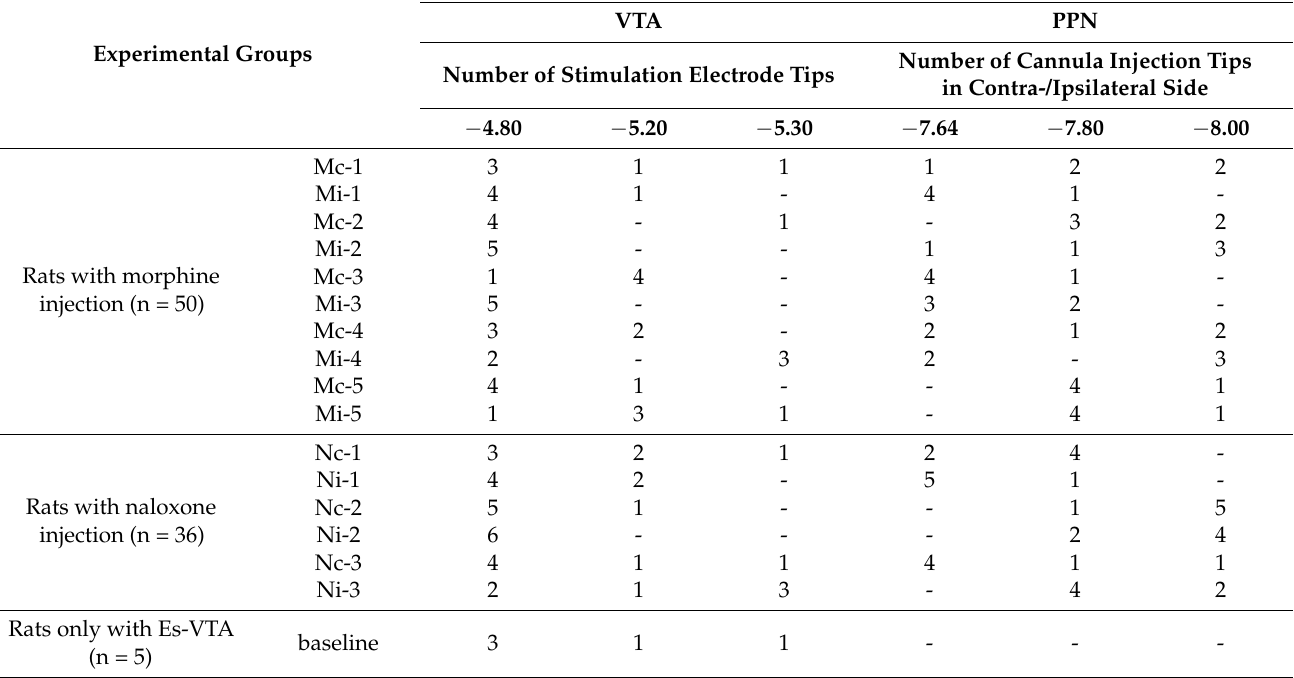
Table 1. Localization of the electrode tips in the ventral tegmental area (VTA) in all rats with unilateral VTA electrical stimulation (Es-VTA) and morphine and naloxone injection (experimental groups, n = 86) and in rats only with Es-VTA (baseline group, n = 5), and localization of the cannula tips in all rats of the experimental groups (n = 86) that received morphine (Mc-1, Mc-2, Mc-3, Mc-4, Mc-5 and Mi-1, Mi-2, Mi-3, Mi-4, Mi-5 groups; n = 50) and naloxone (Nc-1, Nc-2, Nc-3 and Ni-1, Ni-2, Ni-3 groups; n = 36) into the pedunculopontine tegmental nucleus (PPN) according to the rat brain atlas